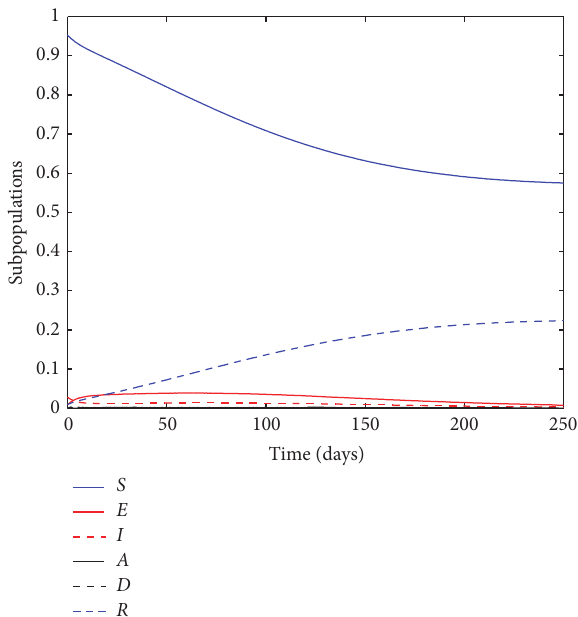
Figure 7: Evolution of the subpopulations with an every other day culling rate of 𝜌 𝐷 = 0.8 .